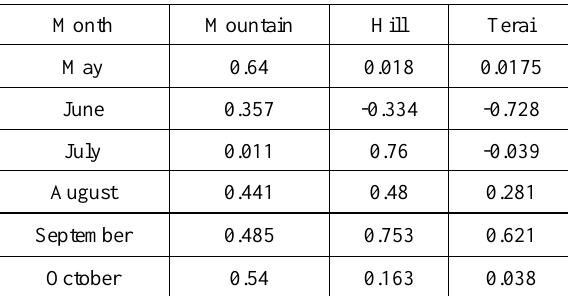
Table 2. Correlation coefficient between NDVI and temperature (r(NDVI, LST)) across different ecological regions during the period of study